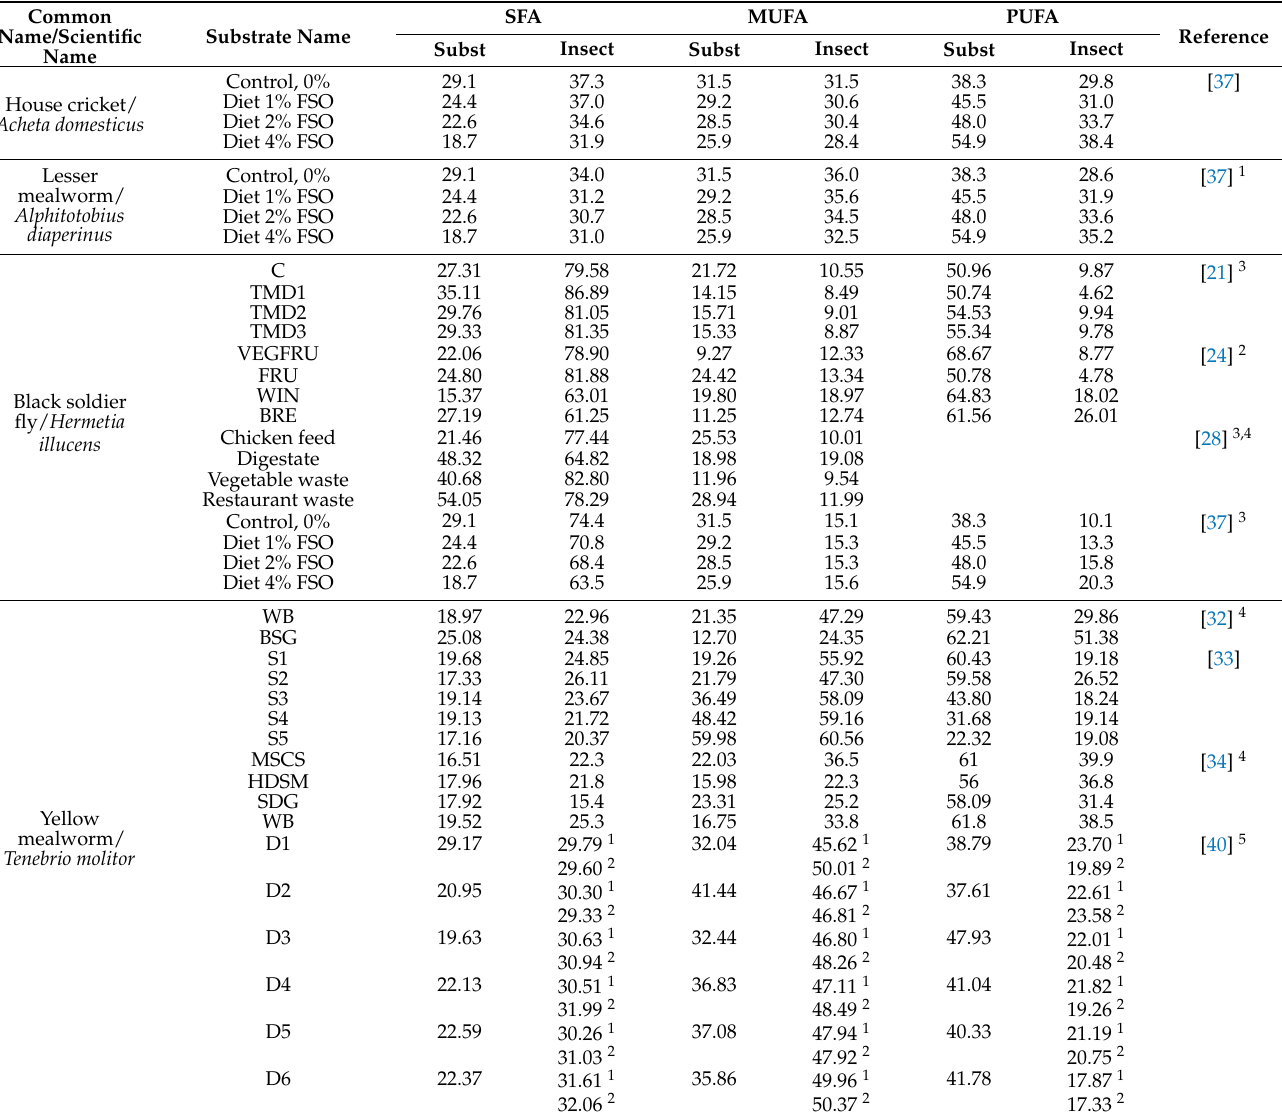
Table 1. Contents (% of total fatty acids) of saturated fatty acids (SFA), monounsaturated fatty acids (MUFA), and polyunsaturated fatty acids (PUFA) in feed substrates and in